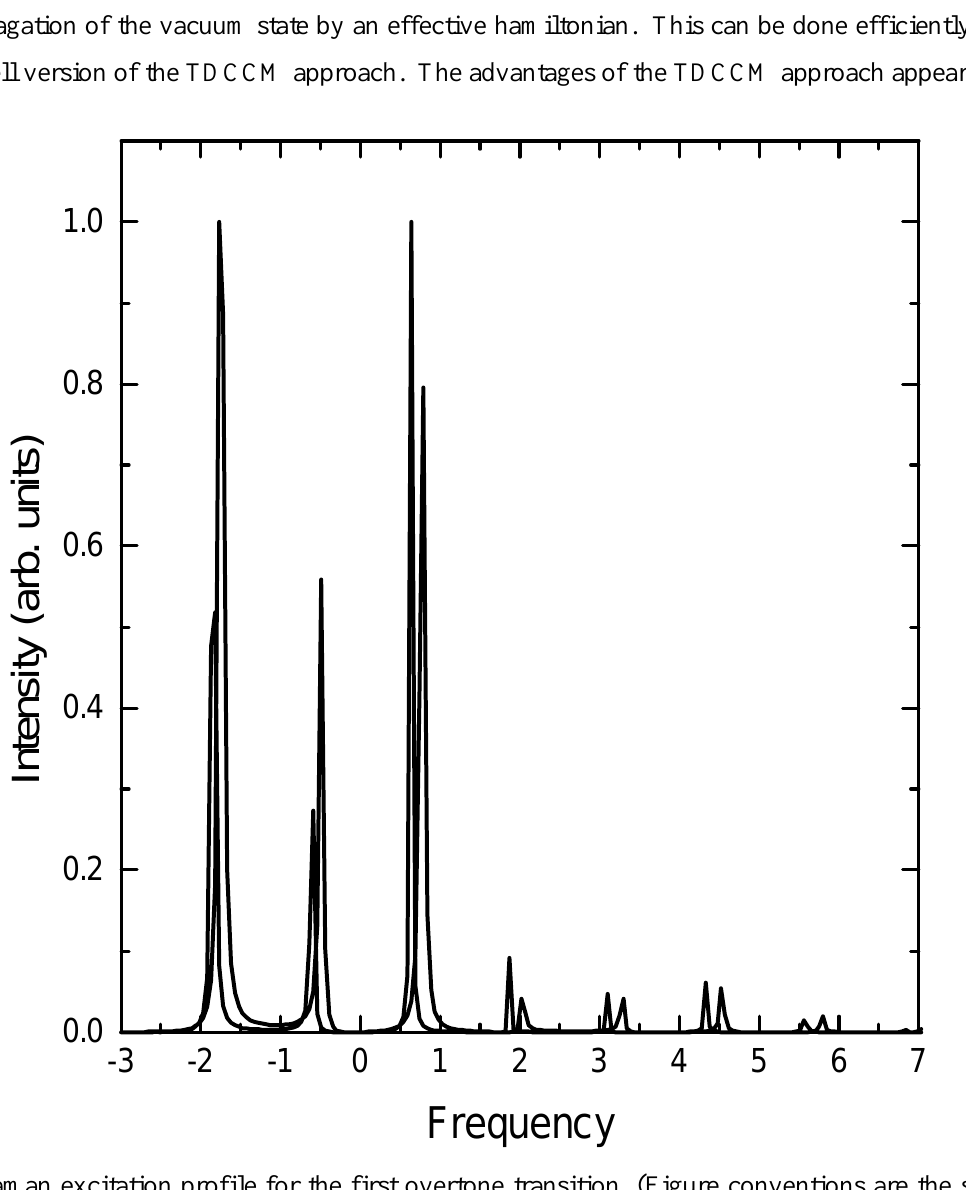
Fig.3: Raman excitation profile for the first overtone transition. (Figure conventions are the same as